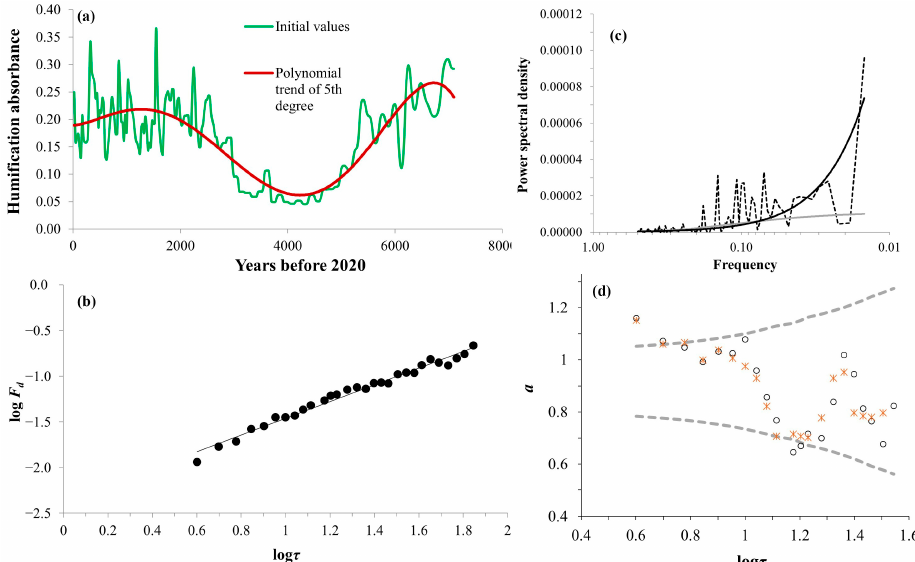
Figure 6. ( a ) Fifth-degree polynomial fit to the humification timeseries. ( b ) Log–log plot of the root mean square fluctuation function, F d , for the detrended 25-year fixed-step timeseries of humification vs. temporal interval τ (25-year step) and the corresponding best fit equation (y = 0.92 · x − 2.38, R 2 = 0.98). ( c ) Power spectral density for the detrended timeseries (dashed black line) with the corre- sponding power-law (black solid line) and the exponential (gray solid line) fit (y = 0.00000012 · x − 1.47 , R 2 = 0.40; y = 0.000011 · e − 8.25 · x , R 2 = 0.44). ( d ) Local slope stability of log F d ( τ ) vs. log τ , calculated for a 10-point window (red crosses) and a 9-point window (black circles) for the detrended 25-year fixed-step timeseries of humification. The dashed gray line represents the corresponding 2 σ threshold range, derived from the 500 fractional noise